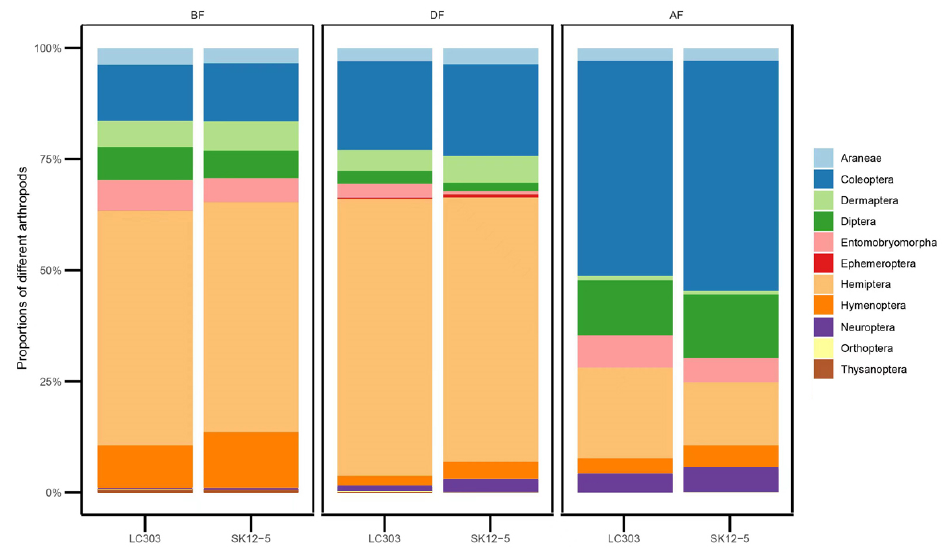
Figure 1. Proportions of all orders of non-target arthropods (NTAs) found in SK12-5 ( Bt ) and LC303